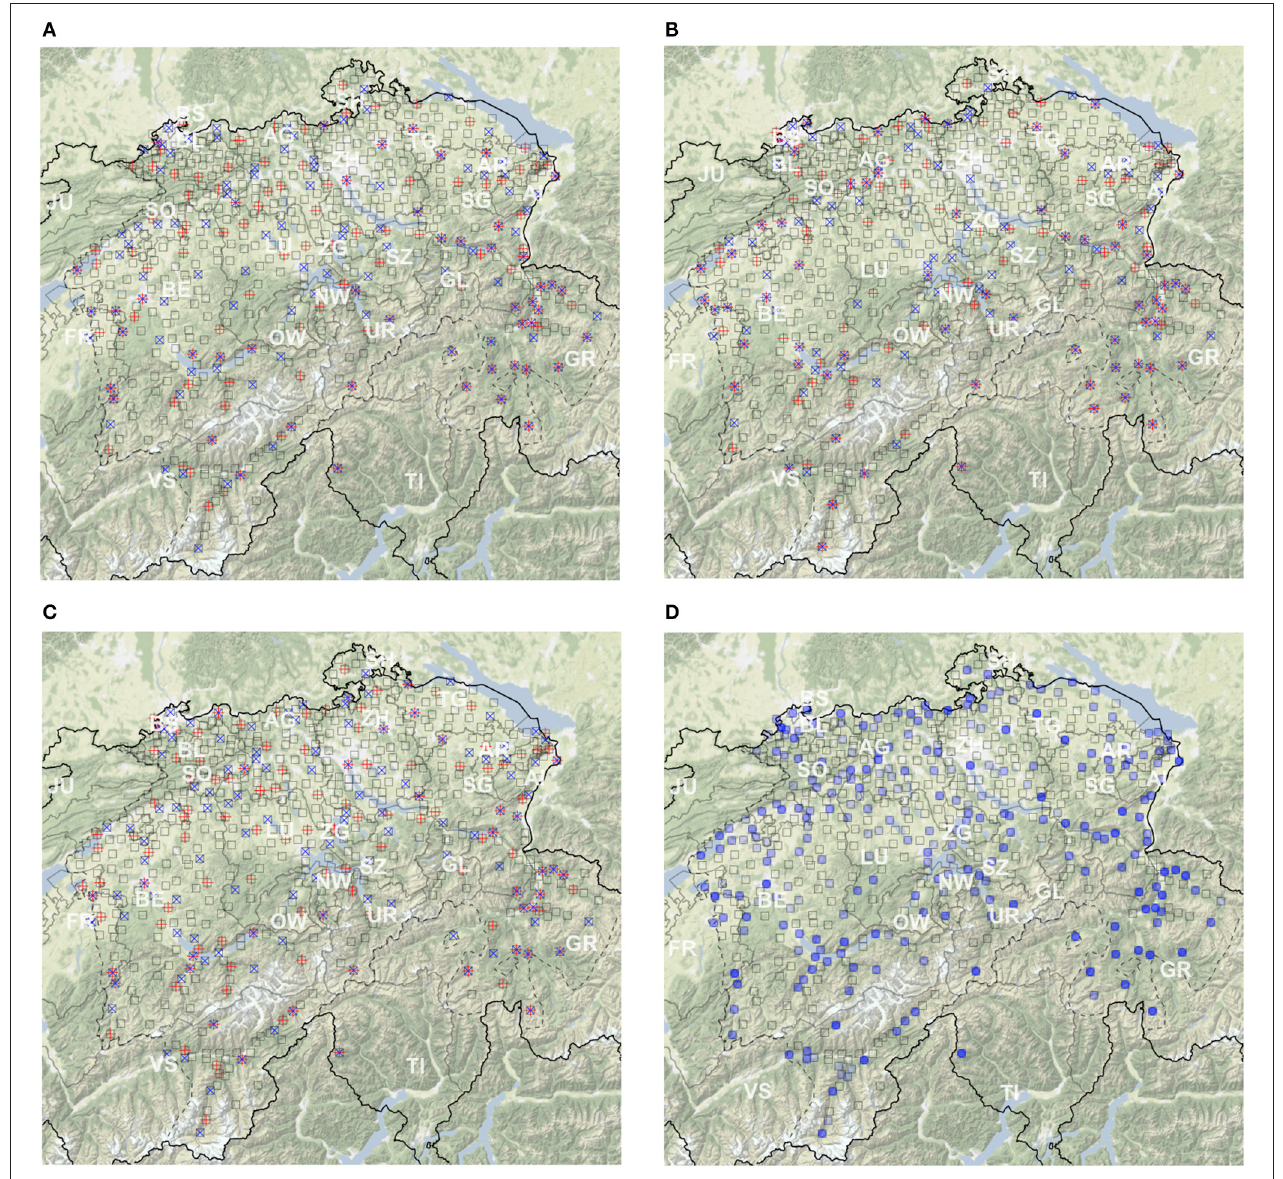
FIGURE 3 | Maps of the two types of candidate survey sites. Centers are appointed by the smallest total linguistic distance within a cluster (red + ), and the highest population within a cluster (blue × ), for each clustering method ( A —PAM; B —UPGMA; and C —Ward’s method). Map (D) shows all candidate survey sites in a stacked manner. All maps contain the original SDS survey sites in the background (gray